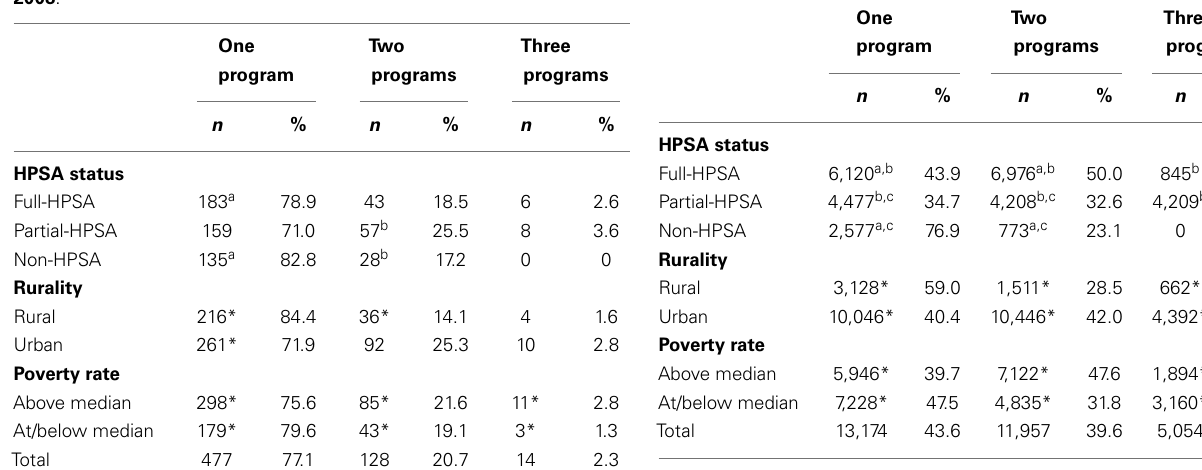
Table 2 | Distribution of counties by availability of multiple Table 3 | Distribution of participants by availability of multiple evidence-based programs (CDSMP,AMOB/VLL, EF) by health profes- sional shortage area (HPSA), rurality, and poverty status in 2008